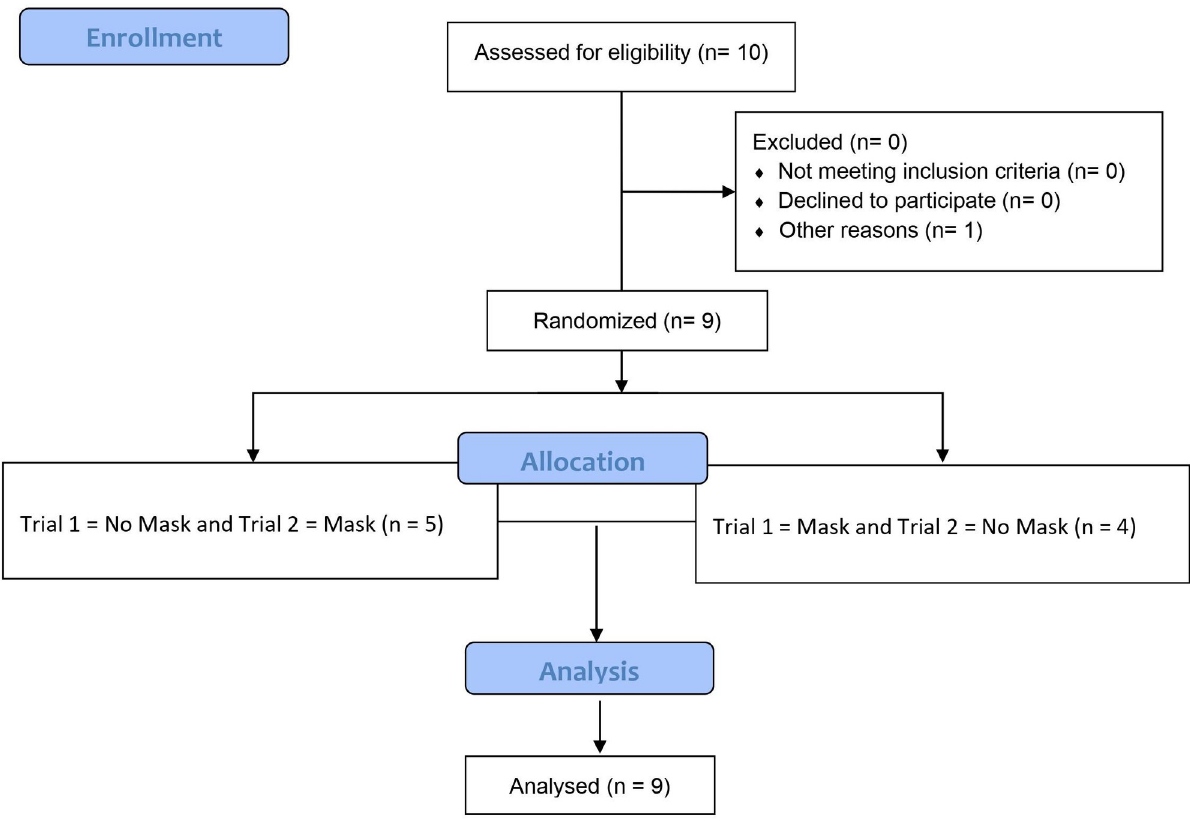
Fig 1. CONSORT flow